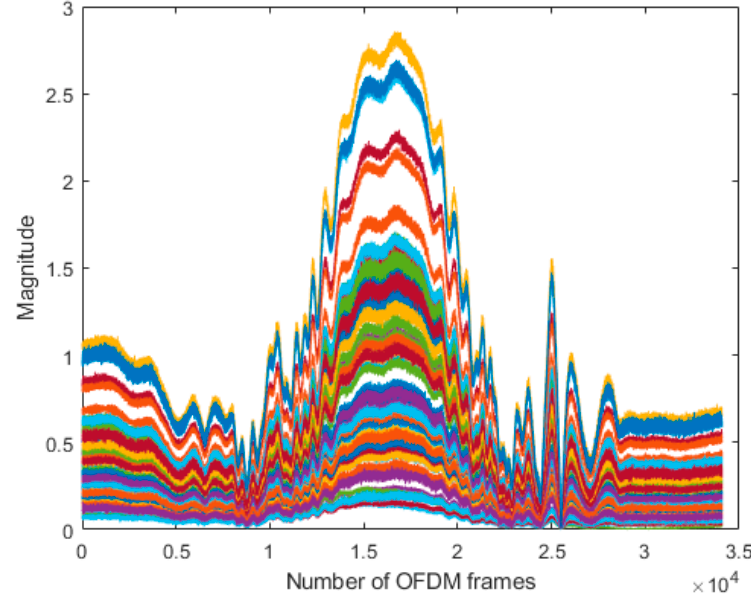
Figure 7. Result of correct activity using 64-subcarriers.